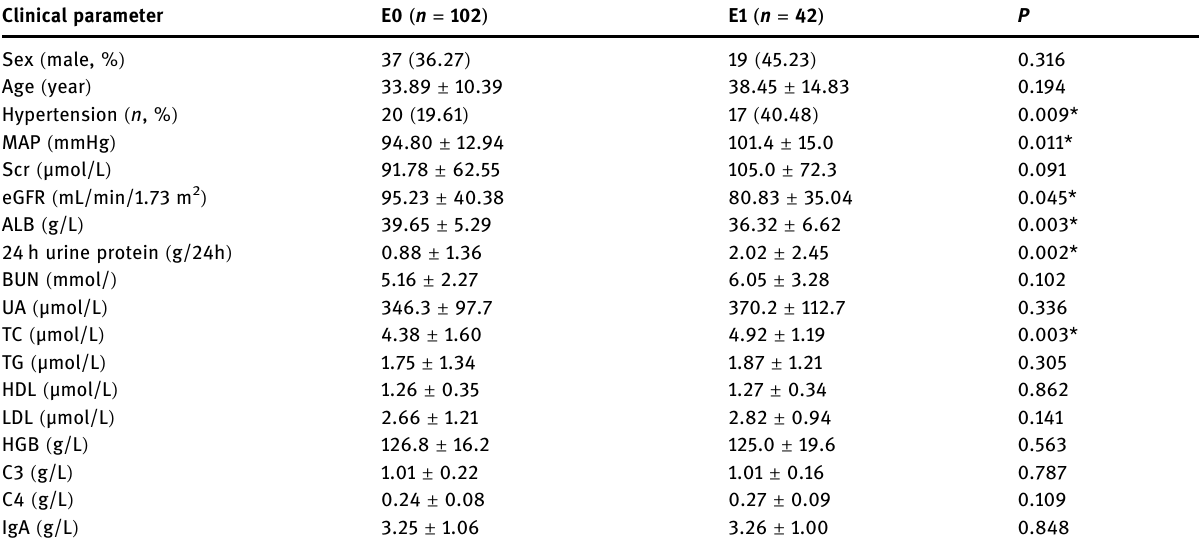
Table A2: Relationship of E score with clinical parameters of patients with IgAN Clinical parameter